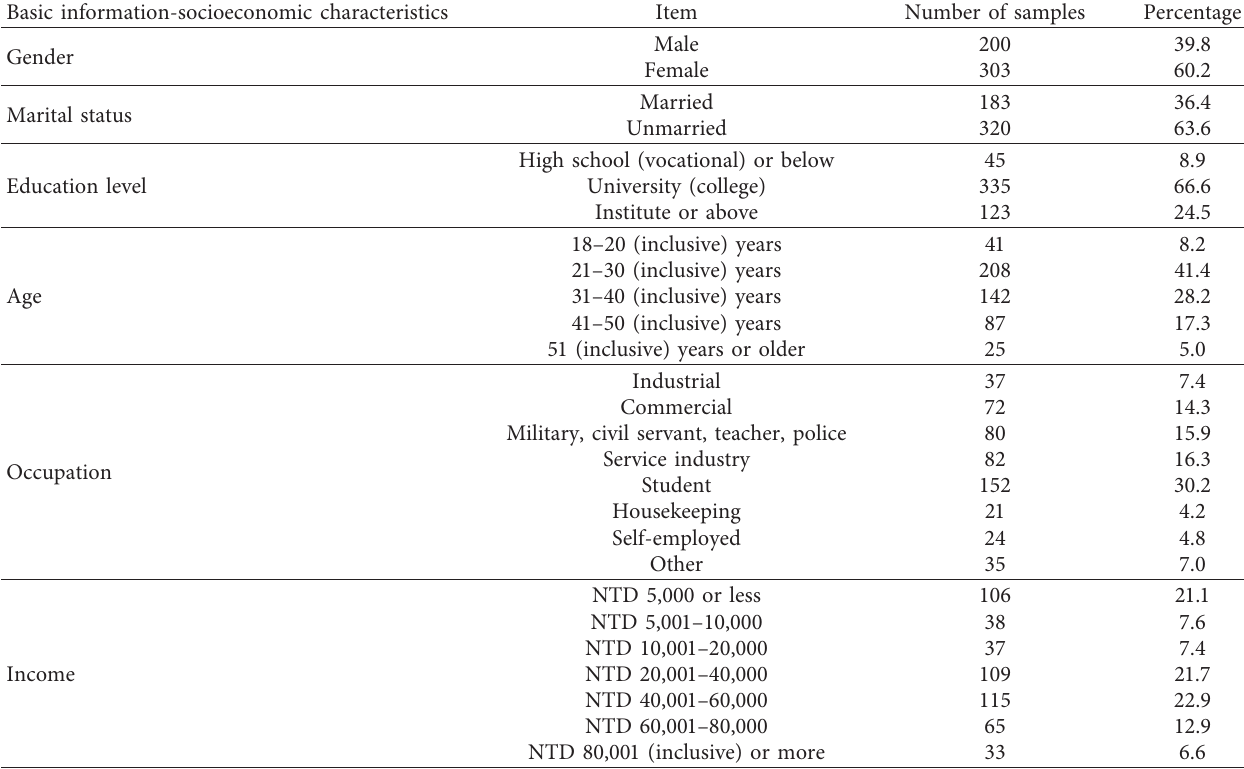
Table 1: Socioeconomic characteristics data